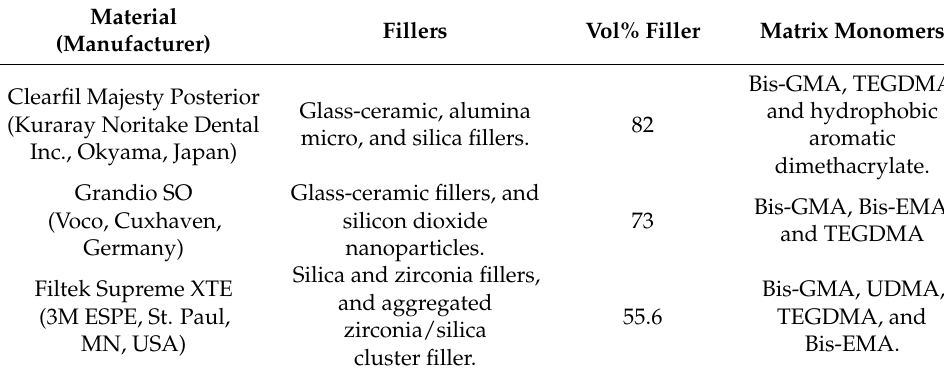
Table 1. Description of materials evaluated.